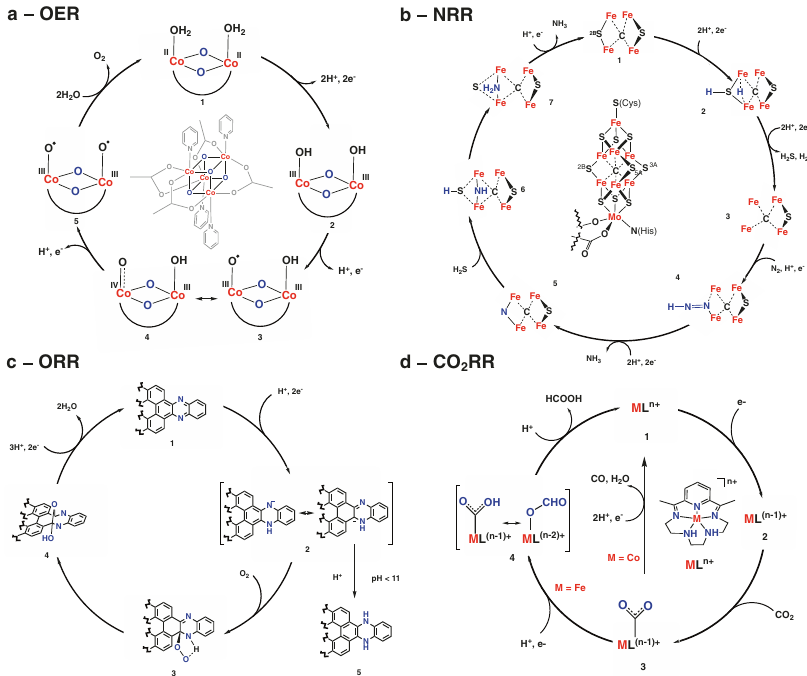
Fig. 4 Catalytic mechanisms deduced from molecular models. a Co-cubane OER catalysts and its catalytic mechanism. Catalyst undergoes four-electron oxidation shared between two Co-centers yielding an oxyl intermediate 5 which then forms O – O bond 75 . b NRR asymmetric mechanism considered as a possible pathway for nitrogenases 78 . c ORR mechanism accepted for metal-free GQDs showing carbanion (3) intermediate which is crucial for O 2 activation. However, if pH is lowered, protonation becomes fast yielding intermediate 5 and shutting off the catalysis 79 . d CO 2 RR mechanism showing branching between CO and formate-forming cycles from intermediate 3. Transition metal used in complex determines the path catalysis undertakes 85